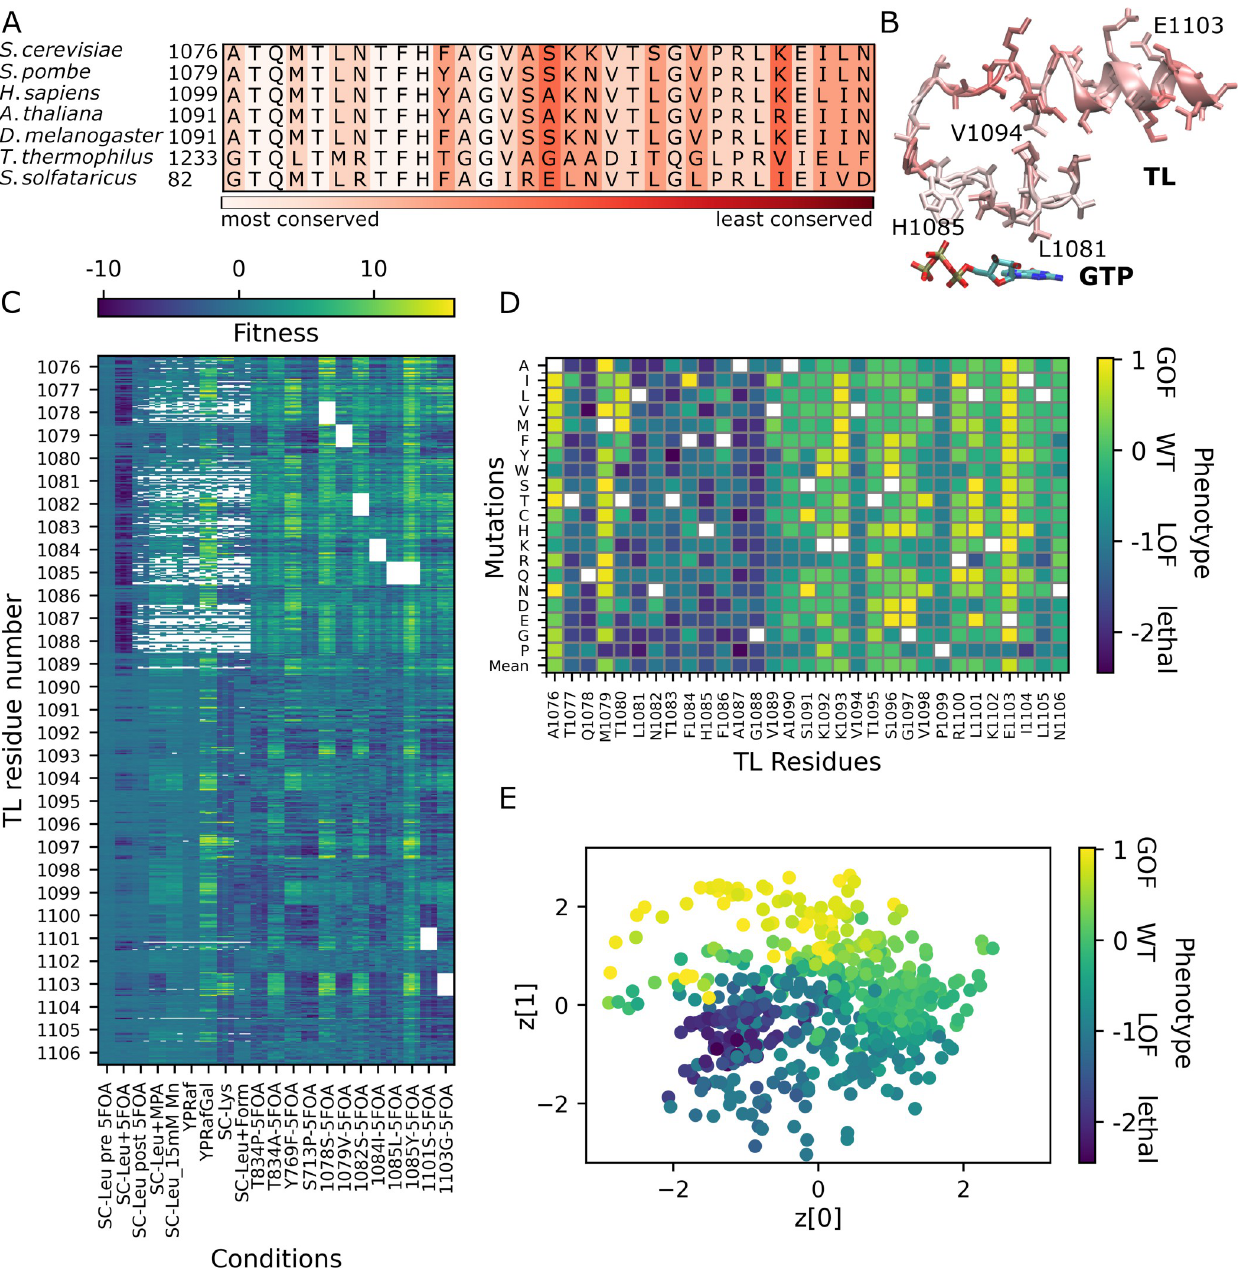
Fig 1. TL sequence conservation and ML prediction of phenotypes from fitness data. (A) Sequence conservation of TL in different organisms that are eukaryotes ( S . cerevisiae and S . pombe from yeast, H . sapiens from mammals, A . thaliana from plants and D . melanogaster from insects), bacterium ( T . thermophilus ), and archaeon ( S . solfataricus ). (B) The structure of TL residues and GTP from S . cerevisiae (PDB code:2E2H). The TL is colored with the level of conservation among the species shown in A. (C) Fitness scores for mutants of TL residues under different conditions (see x-axis labels). The x-axis shows the different conditions with three replicates and the y-axis shows the TL mutations with 19 mutants for each residue, y-axis was labeled by only the TL residue number for avoiding a crowded labeling using all mutant names. For each residue, there are 19 mutants and for each mutant there are 21 data points with three replicates each. (D) Phenotypical landscape predicted from the fitness data. Each box is colored with the phenotype; white boxes reflect the WT amino acid at those positions; the row at the bottom depicted as “Mean” shows the average phenotypes for the residues. (E) Latent space of the unsupervised VAE model based on the fitness data with each data point colored according to its corresponding phenotype. The axes z[0] and z[1] are the first and second dimensions of the 2D latent space generated by projecting the fitness scores using the VAE model.